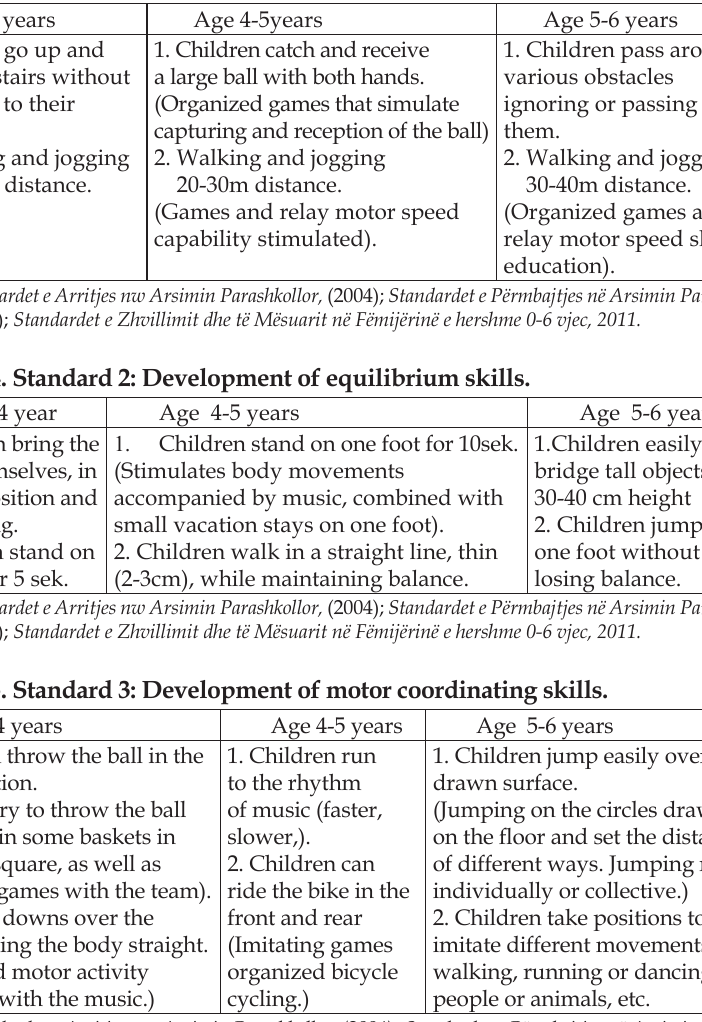
Table 3. Standard 1: Development of basic motor controlling skills.